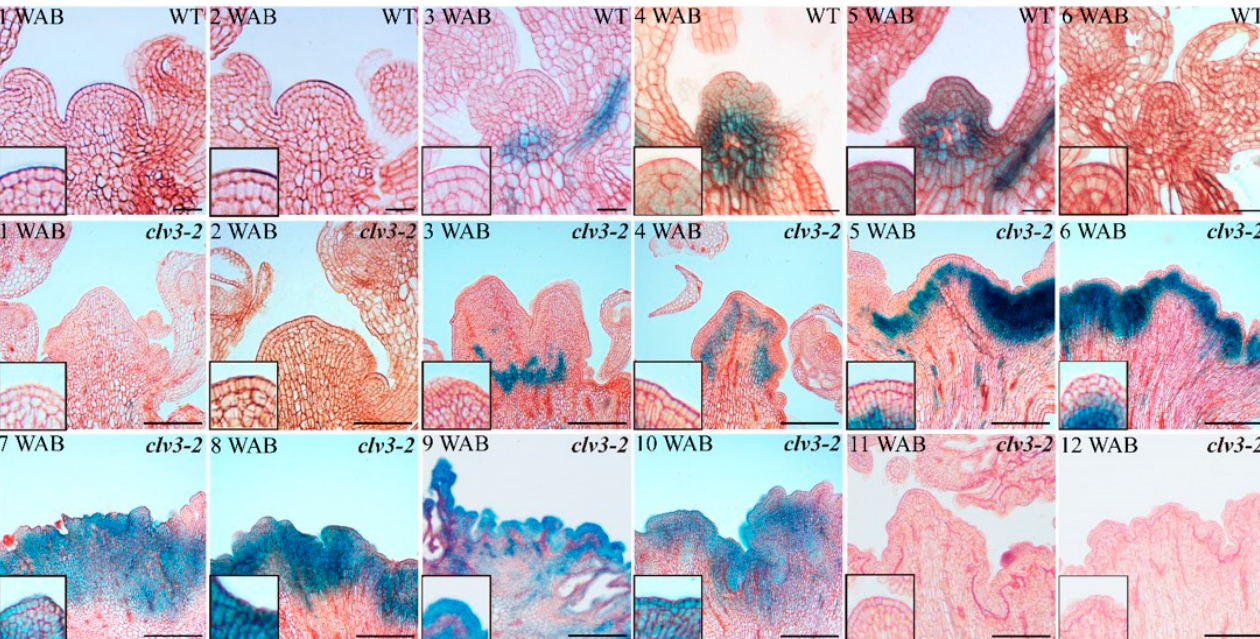
Figure 4. The spatial-temporal expression patterns of BFN1 in WT and clv3-2 mutants. The magnified images at the bottom left corner indicate the BFN1 expression signals (blue color) in stem cell layers. Scale bars: 15 μ m in WT and 100 μ m in clv3-2 .